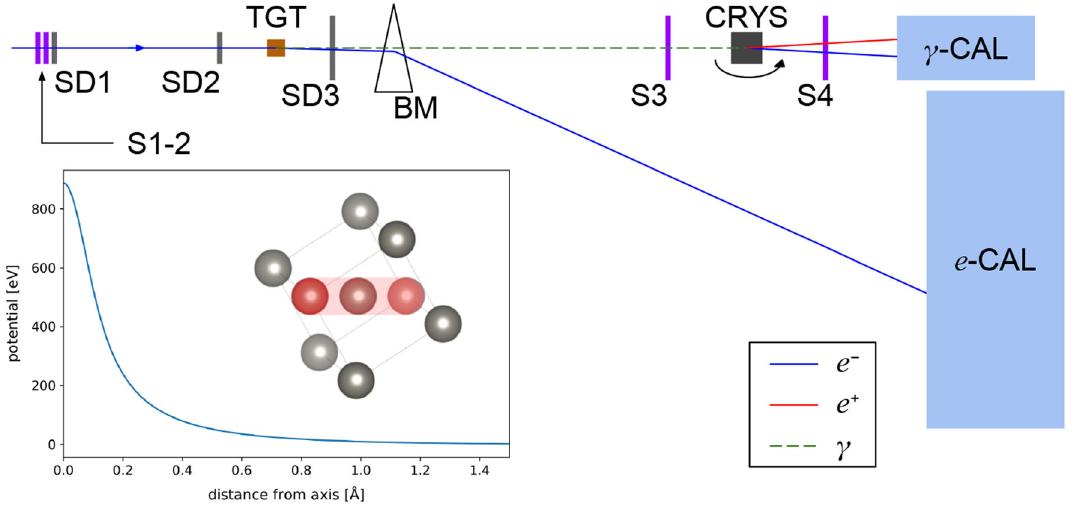
Fig. 1 Experimental setup at the CERN H2 beamline. The input electrons are incident on a thin copper radiator (TGT), producing bremsstrahlung photons; the latter are then separated from the charged beam by a bending magnet (BM). The S1–4 scintillating counters are used to generate the trigger signal (S1 ∧ S2 ∧ S3) and to measure the downstream charged particle multiplicity (S4). The silicon microstrip